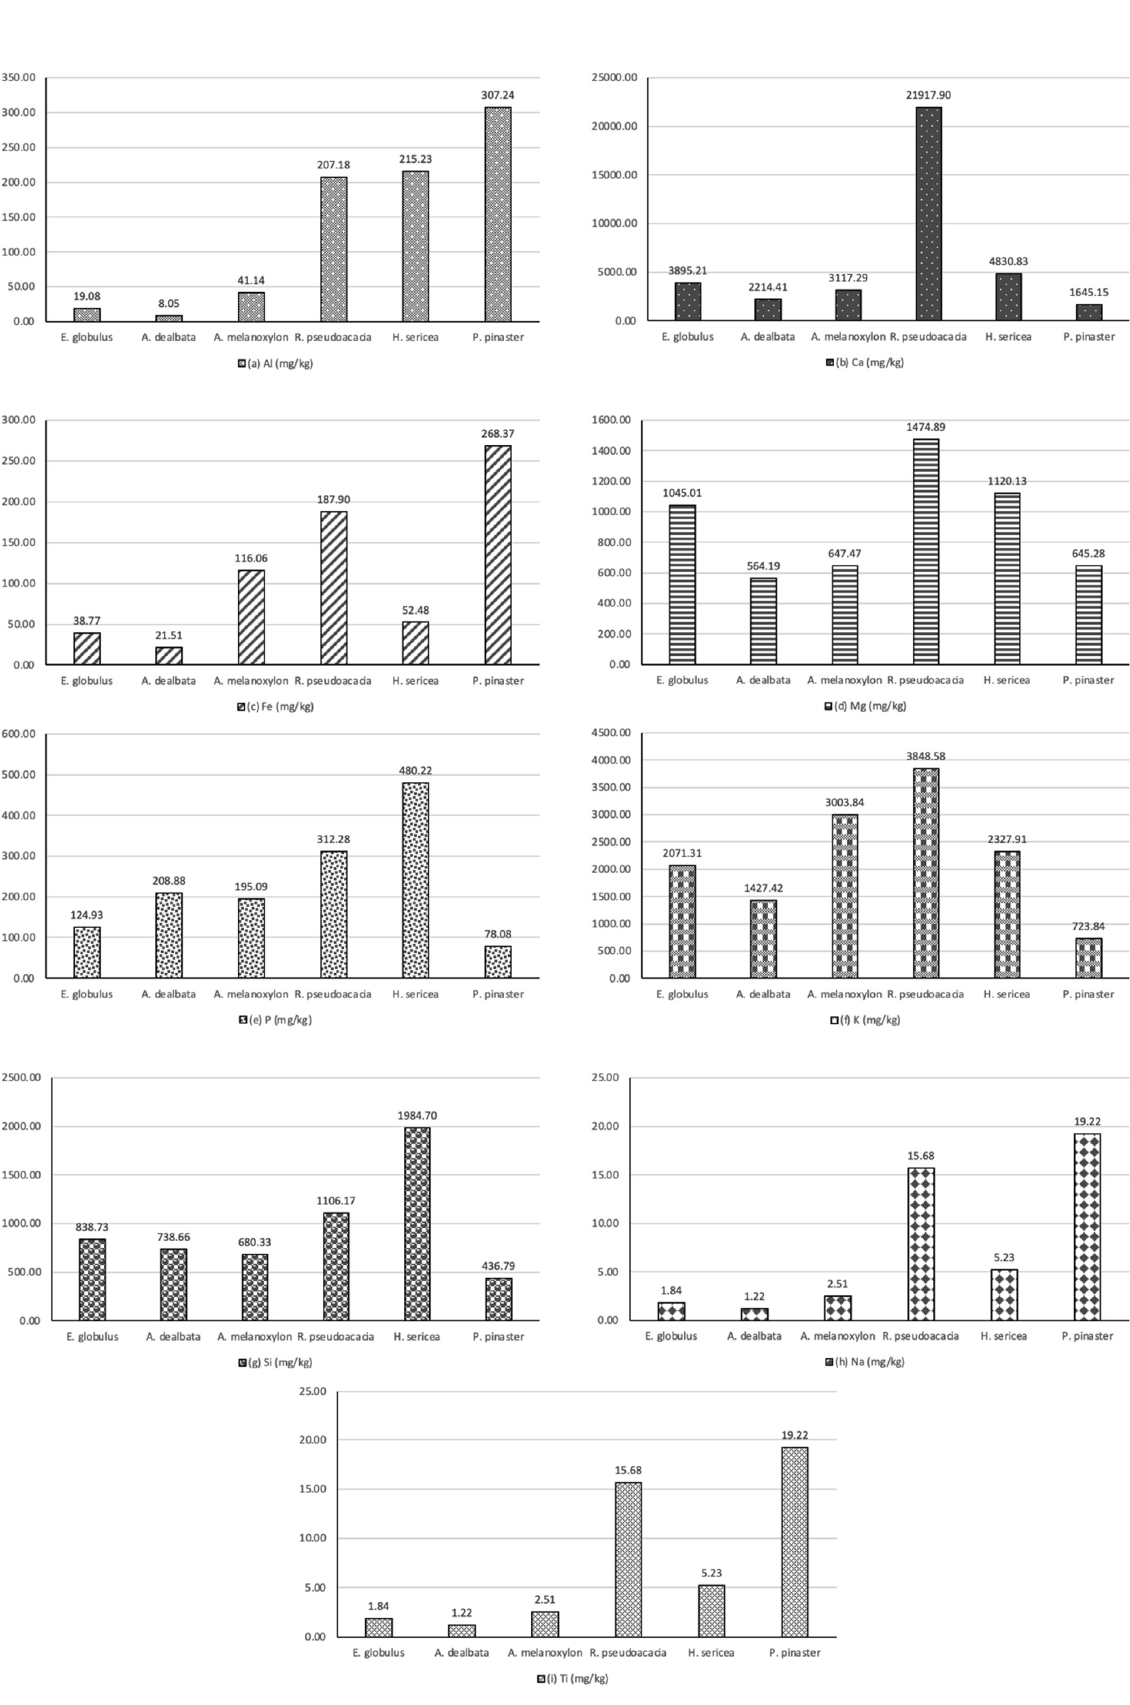
Figure 6. Content of major elements.